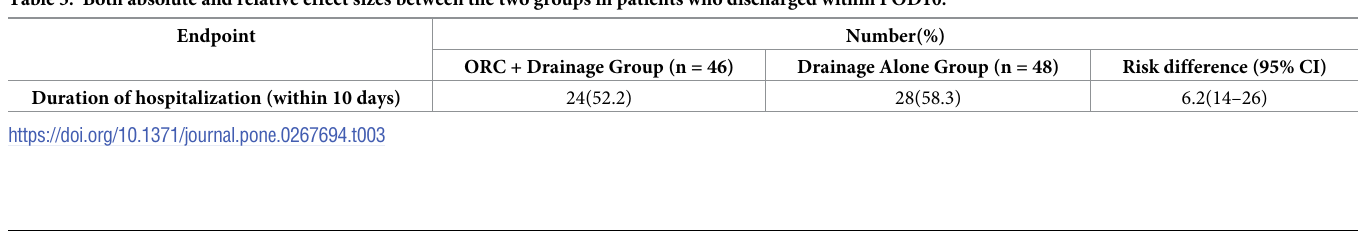
Data are shown as mean ± standard deviation or number (percent).